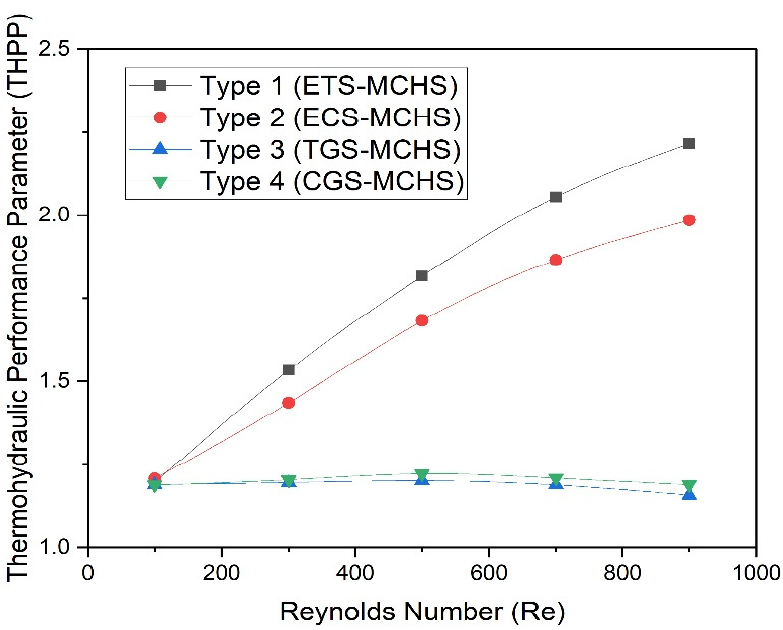
Figure 12. Plots of pumping power with Reynolds numbers for different design types.